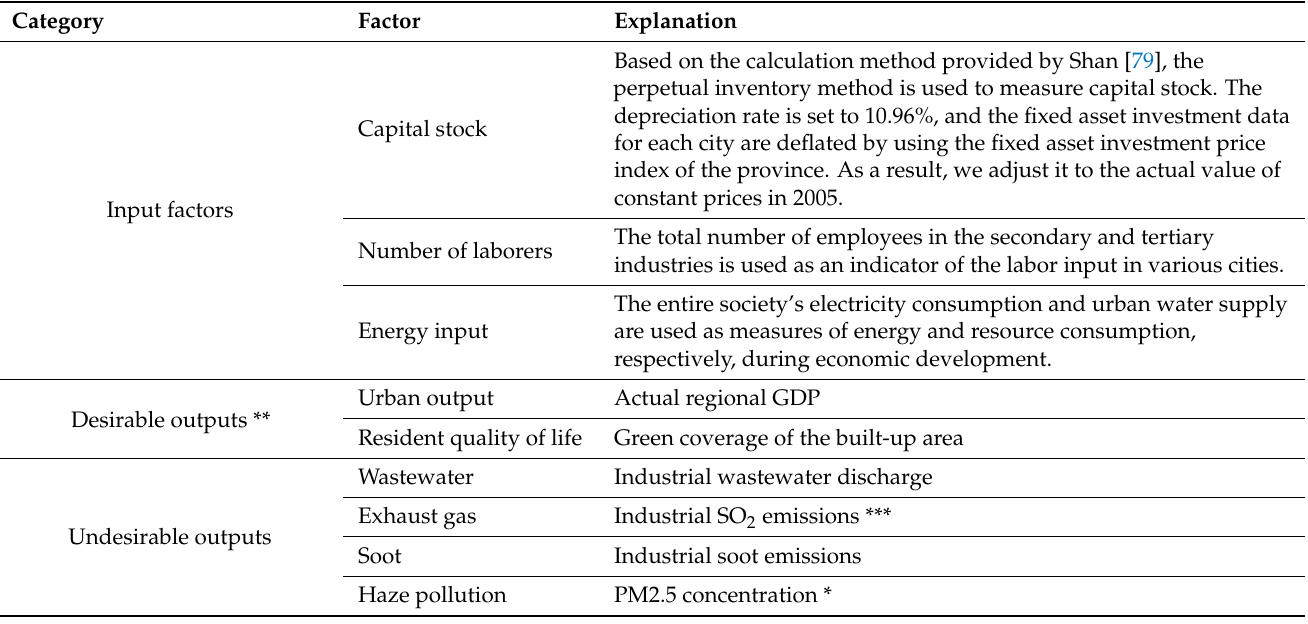
Table 2. Explanation of each indicator.